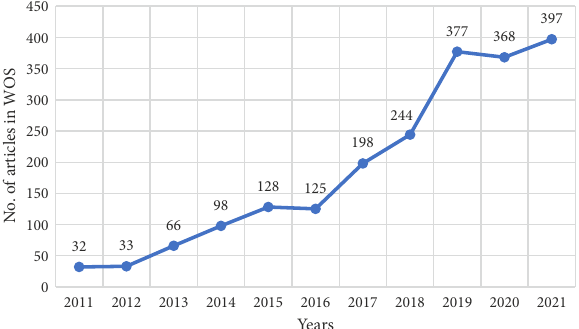
Figure 2. Number of BIM articles published between 2011 and 2021 and retrieved from the WOS core collection